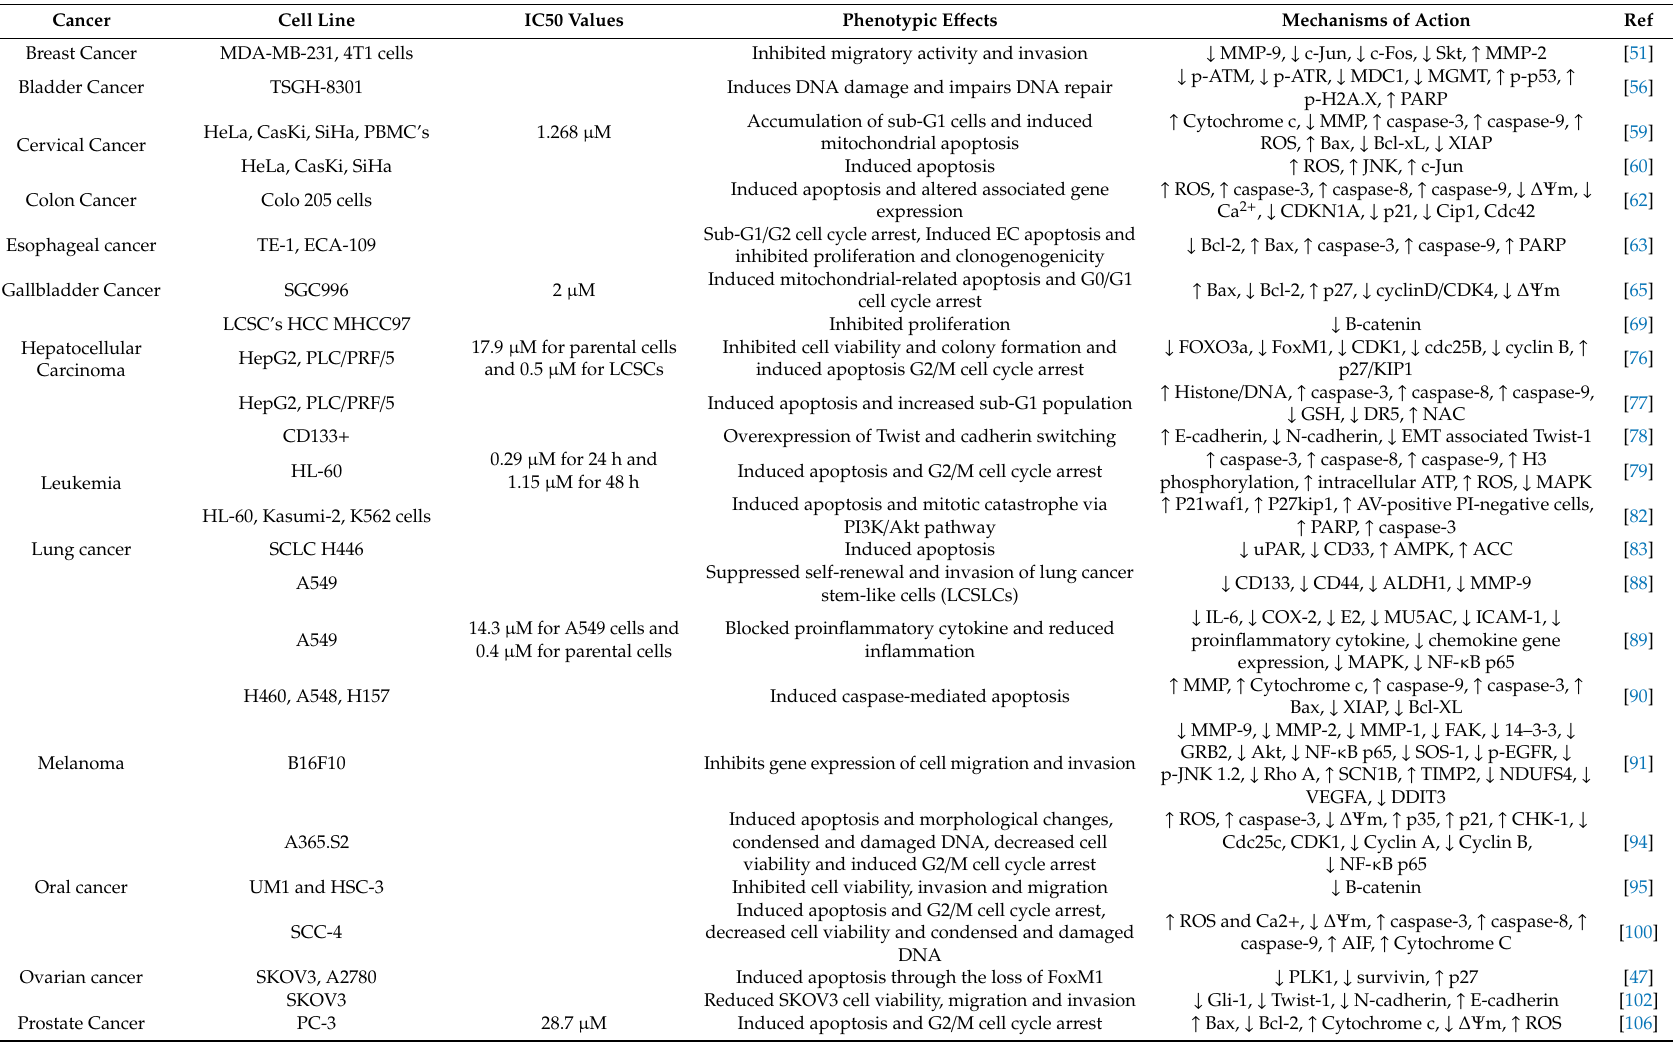
Table 1. Antineoplastic e ff ects of casticin under in vitro settings. ∆Ψ m: mitochondria membrane